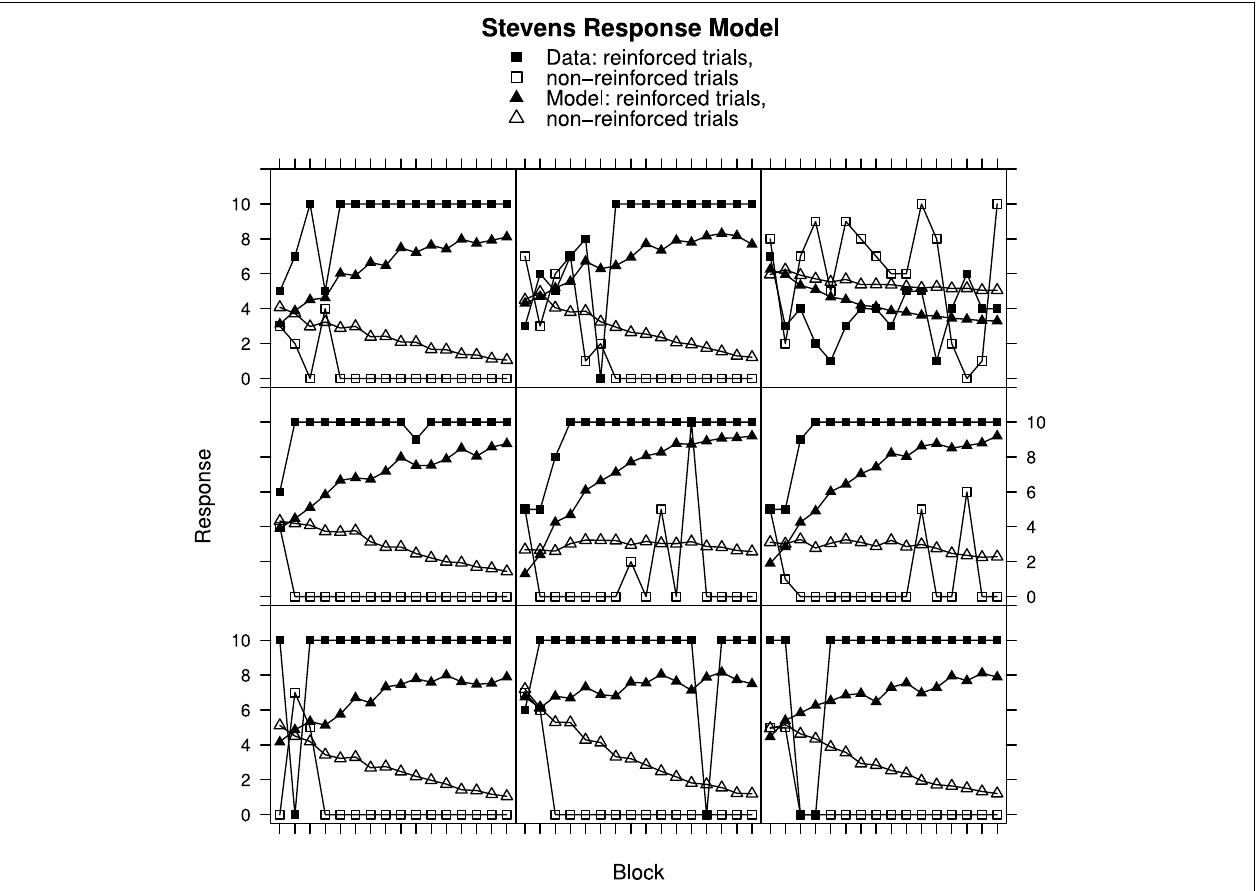
FIGURE 3 | RatingsandRescorla–WagnerModelpredictionsforreinforcedandnon-reinforcedtrialsusingtheStevensResponseModelinExperiment1. Top row , best fitting model samples. Middle row , intermediate fits. Bottom row , worst fitting model samples. See Results section on page 8 for further details.